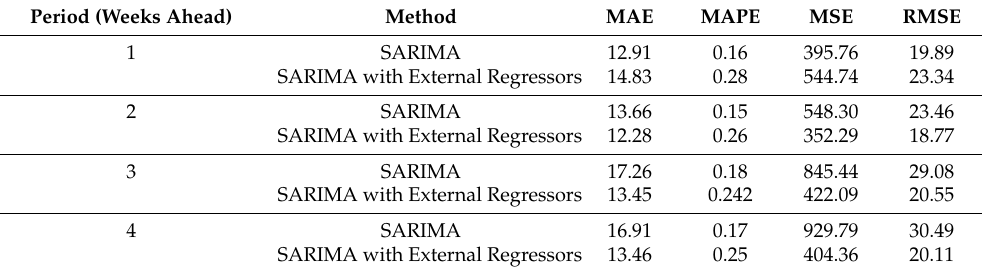
Figure 1. HFMD cases, temperature, rainfall, humidity, trends, and incidence in Sabah 2010–2018. ( a ) Mean temperature, ( b ) maximum temperature, ( c ) minimum temperature, ( d ) mean rainfall, ( e ) mean relative humidity, ( f ) Google search trends, ( g ) HFMD cases, and ( h ) spatial distribution of incidence. Table 2. Validation of selected SARIMA and SARIMA with external regressors